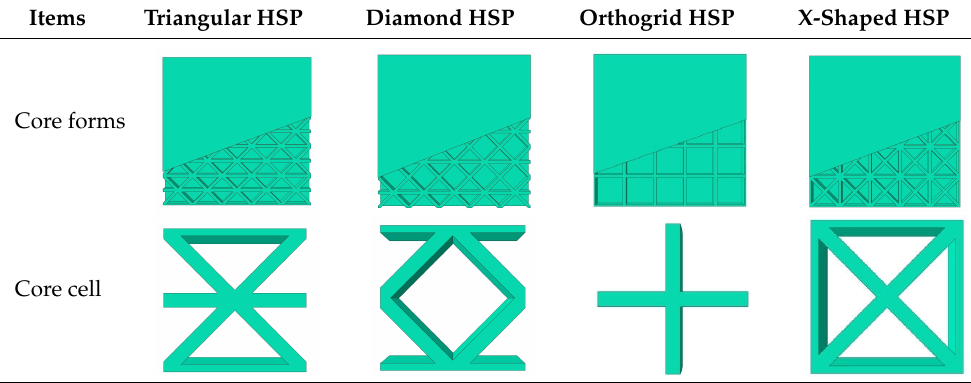
Table 8. Geometries of honeycomb sandwich panels with different core